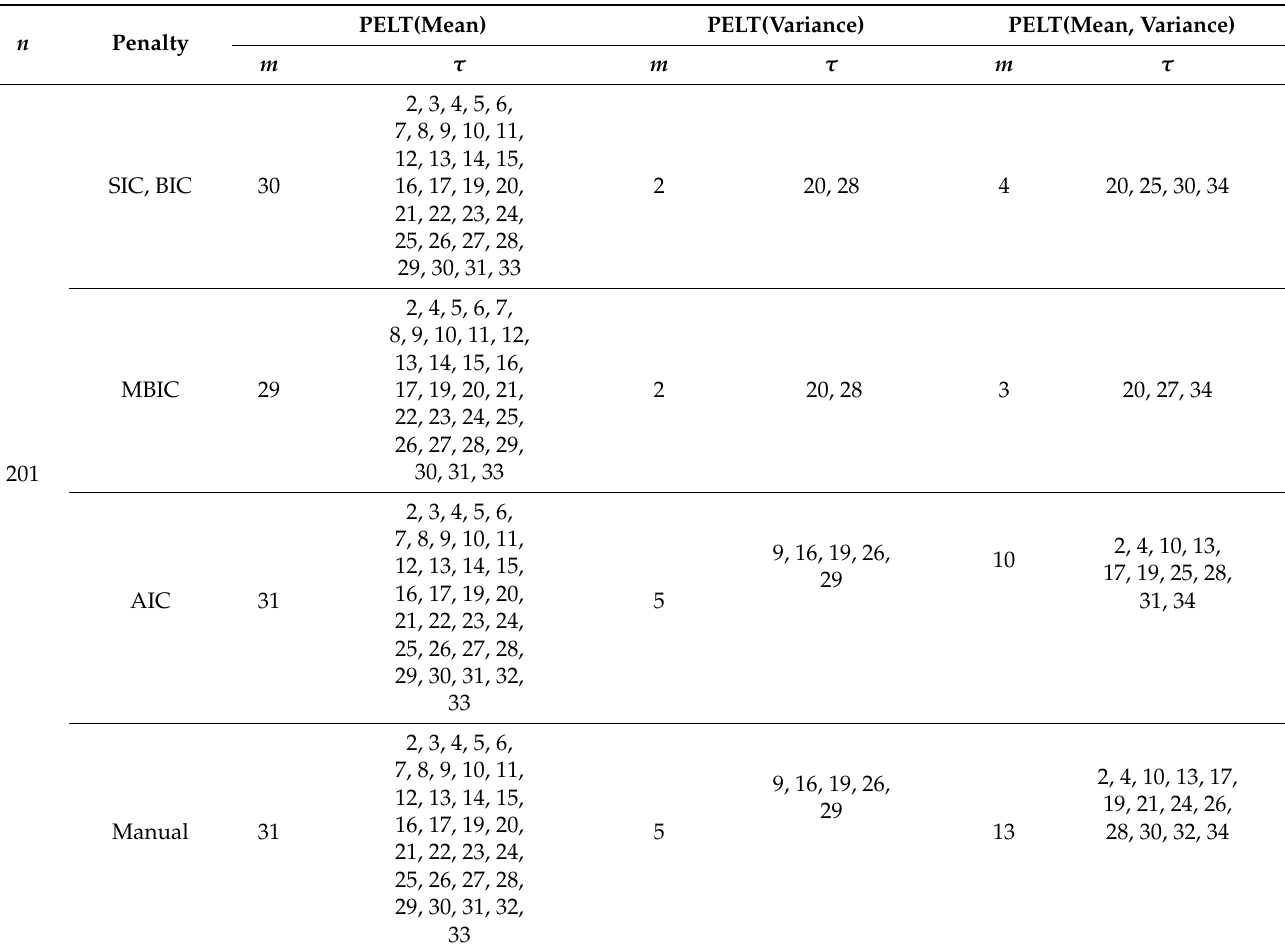
Table A6. PELT Algorithm Result for Simulated Infection.